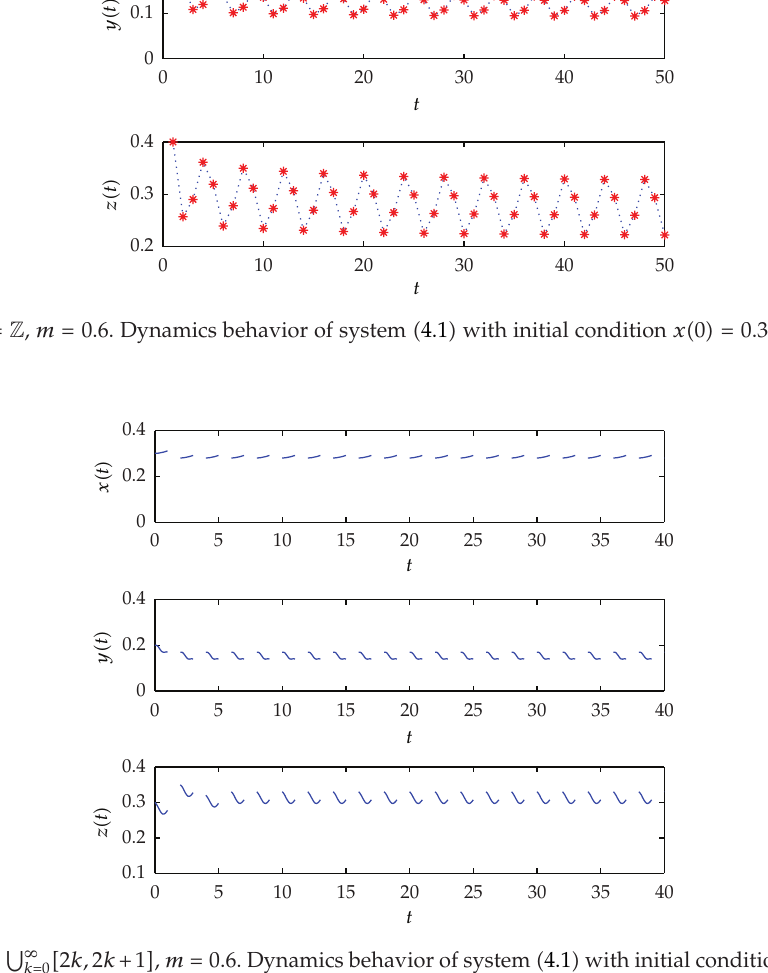
(cid:6) H (cid:7) f u − d l (cid:9) 1 . 5500 > 0; 2 1 (cid:6) H (cid:7) (cid:6) g u − p l d l (cid:7) /p l − k l d l 4 2 (cid:6) H (cid:7) b l − d u (cid:6) 1 − m (cid:7) /a l − h u (cid:6) 1 − m (cid:7) /n l (cid:9) 0 . 0100 > 0; 6 (cid:6) H (cid:7) f l − d u (cid:9) 1 . 0500 > 0; 8 1 (cid:6) H (cid:7) (cid:6) m (cid:7)(cid:6) 1 − m (cid:7)(cid:6) g l − d u 10 1 / 2